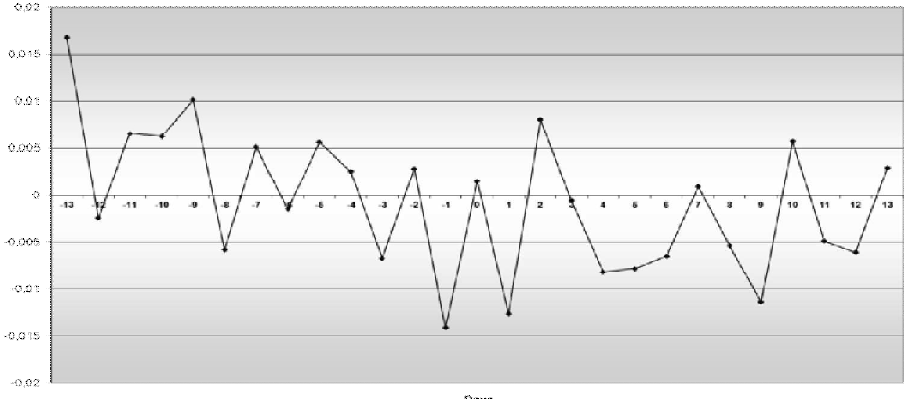
Fig. 7. Abnormal returns in the market model (reverse stock splits)